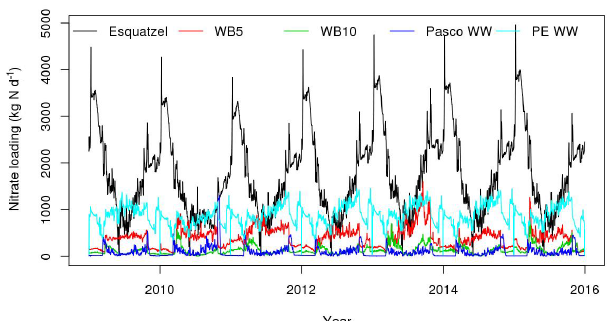
Figure 9. Nitrate loadings at five wasteways along the Columbia